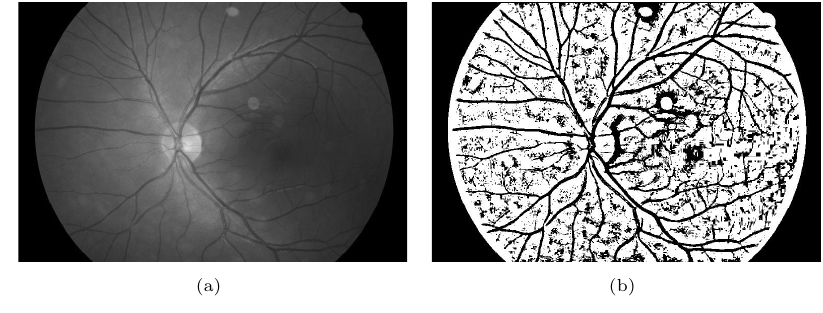
Figure 1. Identifying the blood vessels: (a) original image, (b) extracted vasculature using standard Sauvola